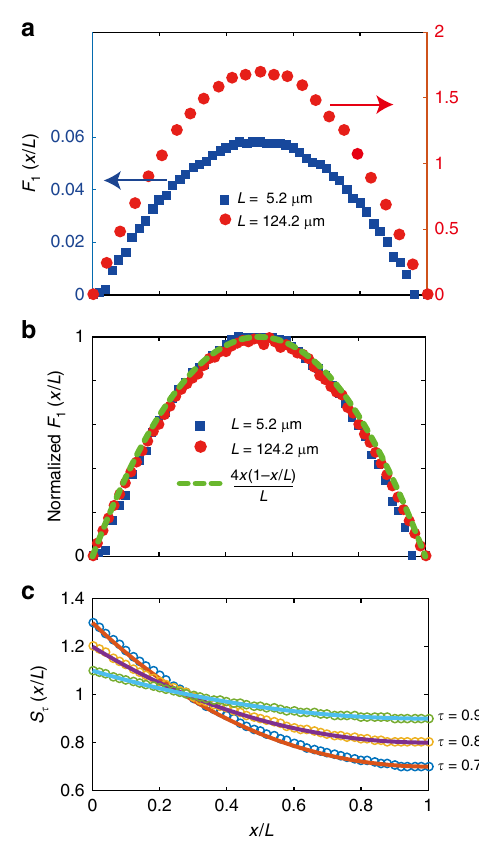
Fig. 4 Pro fi les of energy density in transmission eigenchannels. a Pro fi les of completely transmitting eigenchannel in the translucent and diffusive regimes. b Pro fi les of F 1 ( x/L ) = W 1 ( x/L ) − 1 normalized by its peak value in the center of the sample for translucent and diffusive samples collapse to 4 × ( L − x )/ L 2 . c Comparison of S τ ( x/L ) found from simulations compared with the expression, S τ ( x / L ) = 2 τ cosh 2 ((1 − x / L ) L / ξ ′ ) − τ , for values of τ = 0.7, 0.8, and 0.9 in a sample with L / ℓ = 0.18. S τ ( x / L ) for small values of τ are not shown because they either do not occur, or occur too infrequently for good statistics to be collected for the energy density pro fi